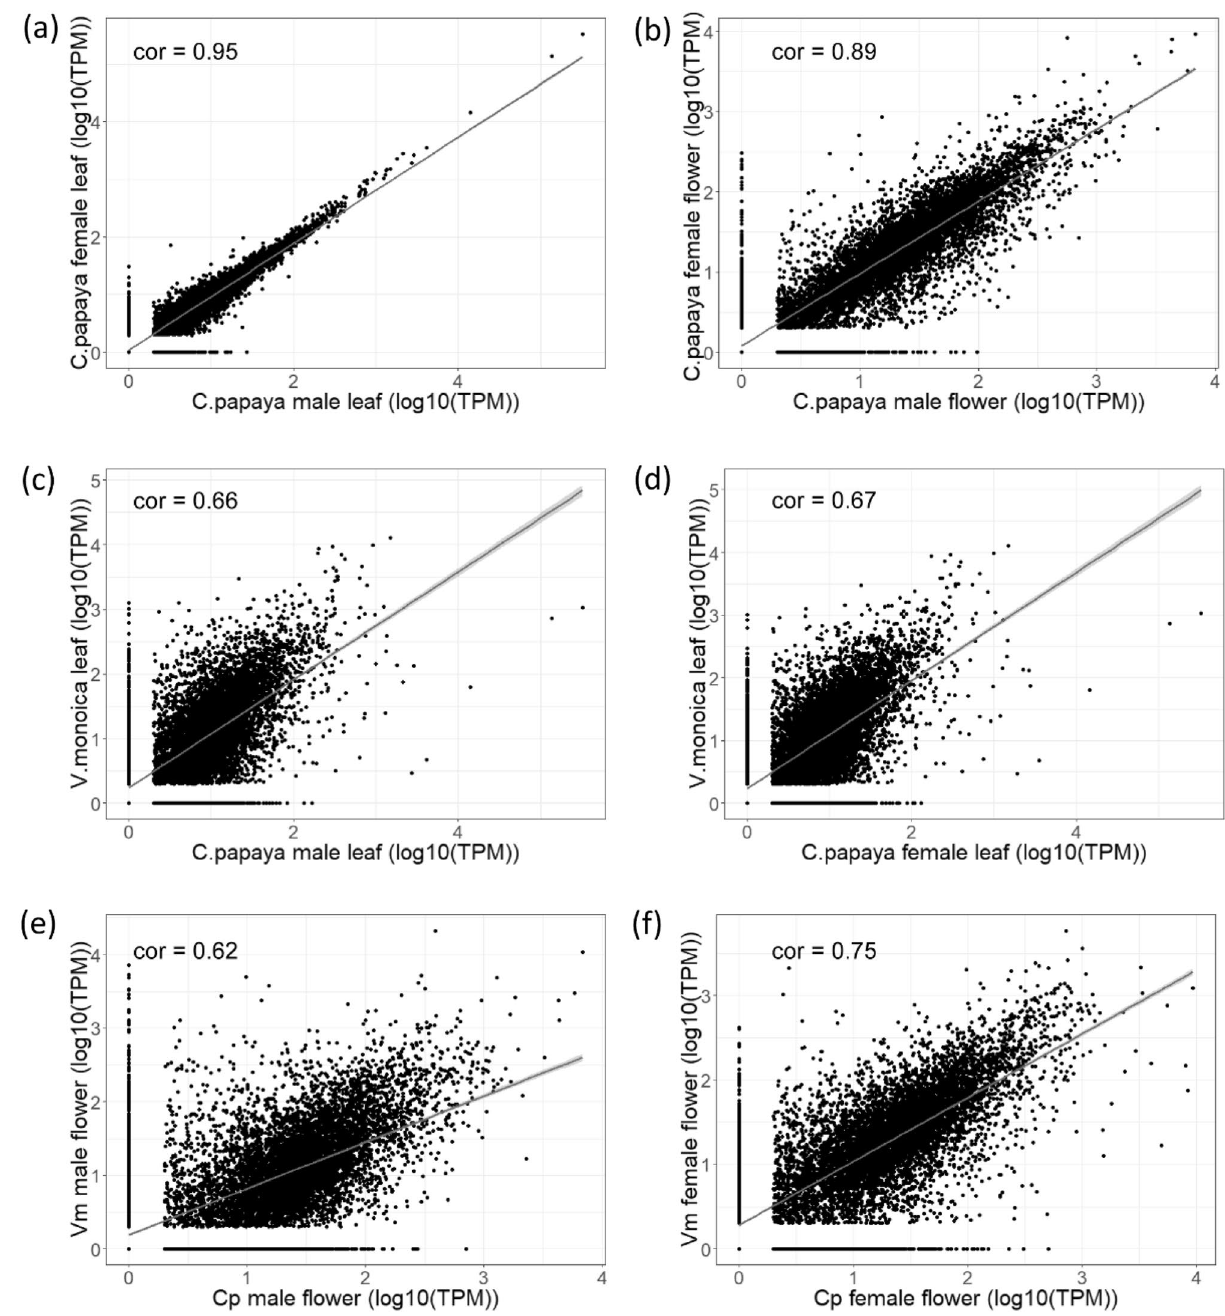
Figure 1. Plot of gene expression (log 10 (TPM)) between male and female papaya leaves ( a ), between male and female papaya flowers ( b ), between V. monoica leaf and papaya male and female leaves ( c , d ), and between V. monoica and papaya male and female flowers ( e , f ). The best fit line was draw in blue. Correlated rate was estimated by Pearson’s